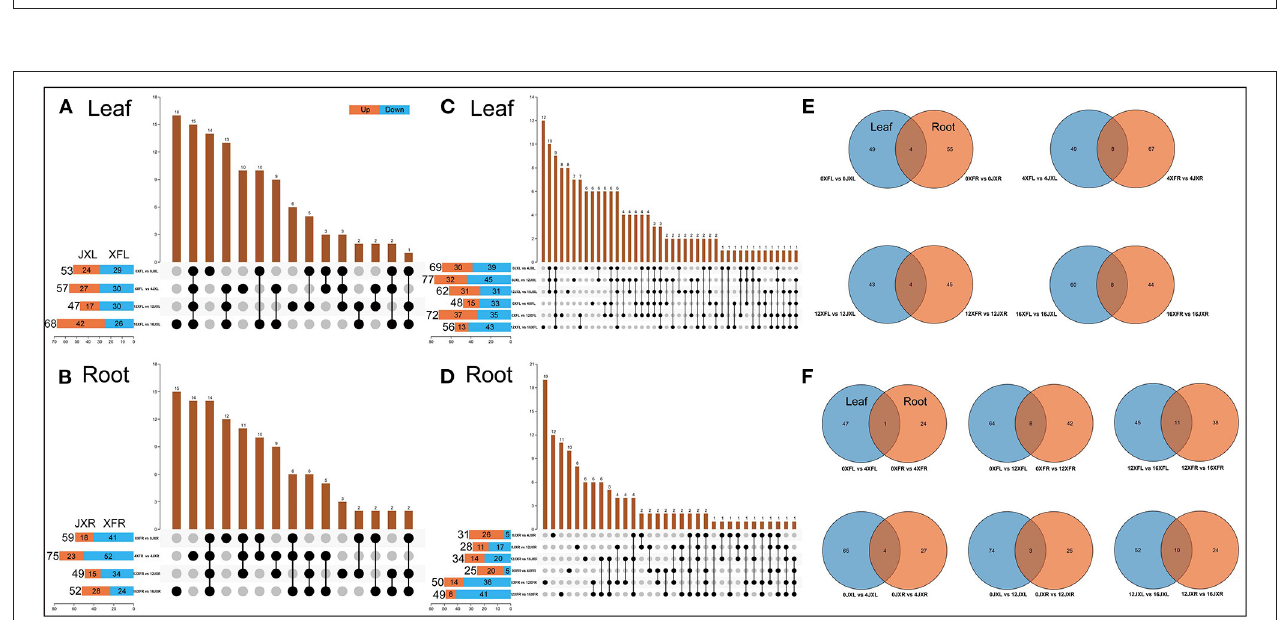
FIGURE 5 | The Venn analysis of differential metabolites involved in leaves and roots of two tea cultivars. The value of the row represents the total number of differential metabolites and “vs.” means that the latter value to the previous value. Orange means the latter value is larger, while blue means the previous is larger. The value of the columns indicates the number of metabolites that are common to several sets of comparisons. (A) Comparison of leaf differential metabolites among cultivars in different shading periods. (B) Comparison of root differential metabolites among cultivars in different shading periods. (C) Comparison of leaf differential metabolites between different shading periods within the same cultivar. (D) Comparison of root differential metabolites between different shading periods within the same cultivar. (E) Differential metabolites shared in leaves and roots among two cultivars during the same shading period. (F) Differential metabolites shared in leaves and roots with the different shading duration. XFL, the leaf of “Xiangfeicui” cultivar; JXL, the leaf of “Jinxuan” cultivar; XFR, the root of “Xiangfeicui” cultivar; JXR, the root of “Jinxuan” cultivar.